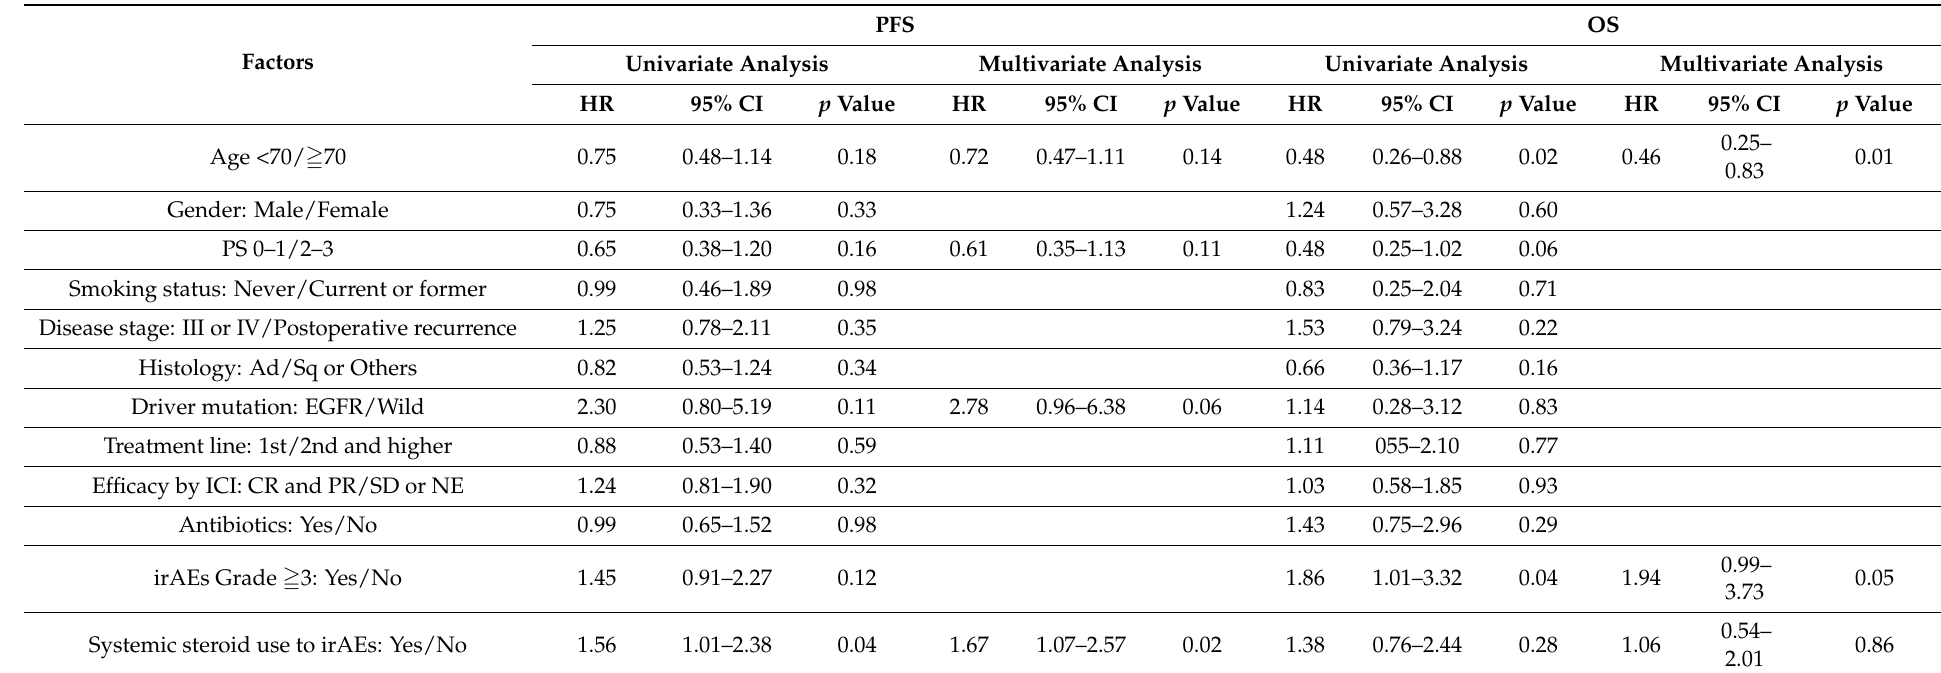
Table 2. Associations of clinical factors with PFS and